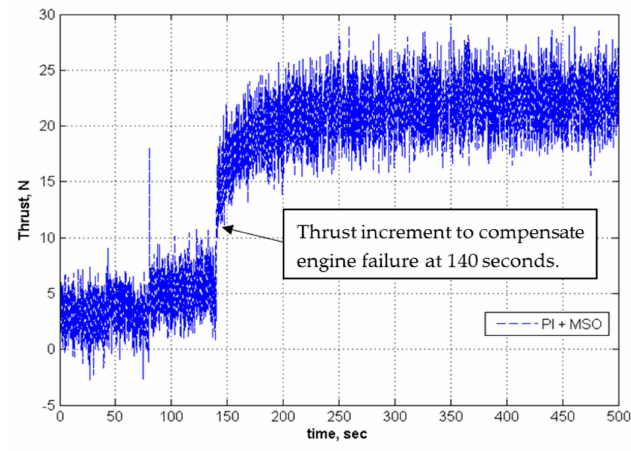
Figure 10. Commanded thrust response for 100% C m α .